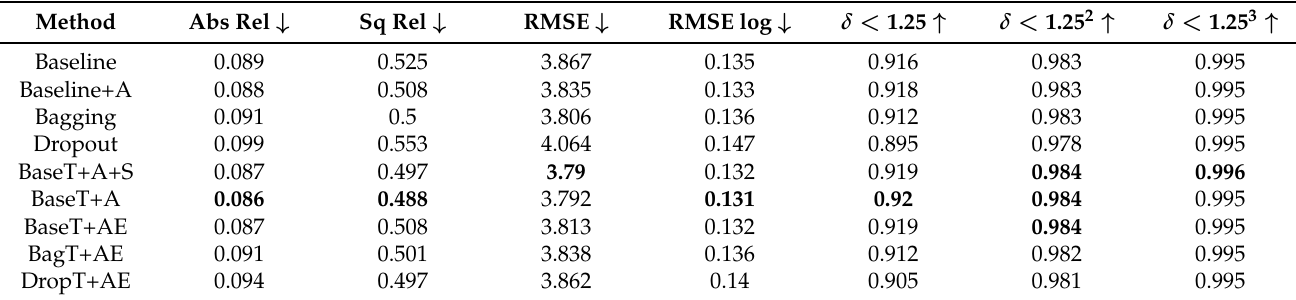
Table 4. Quantitative results of our different strategies for depth evaluation on KITTI new benchmark [61]. The best results in each metric are shown in bold.